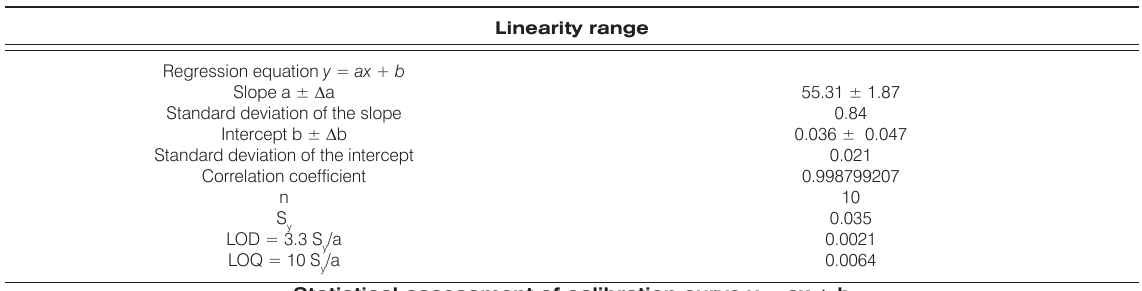
Table 2. Validation report for the RP-HPLC method.